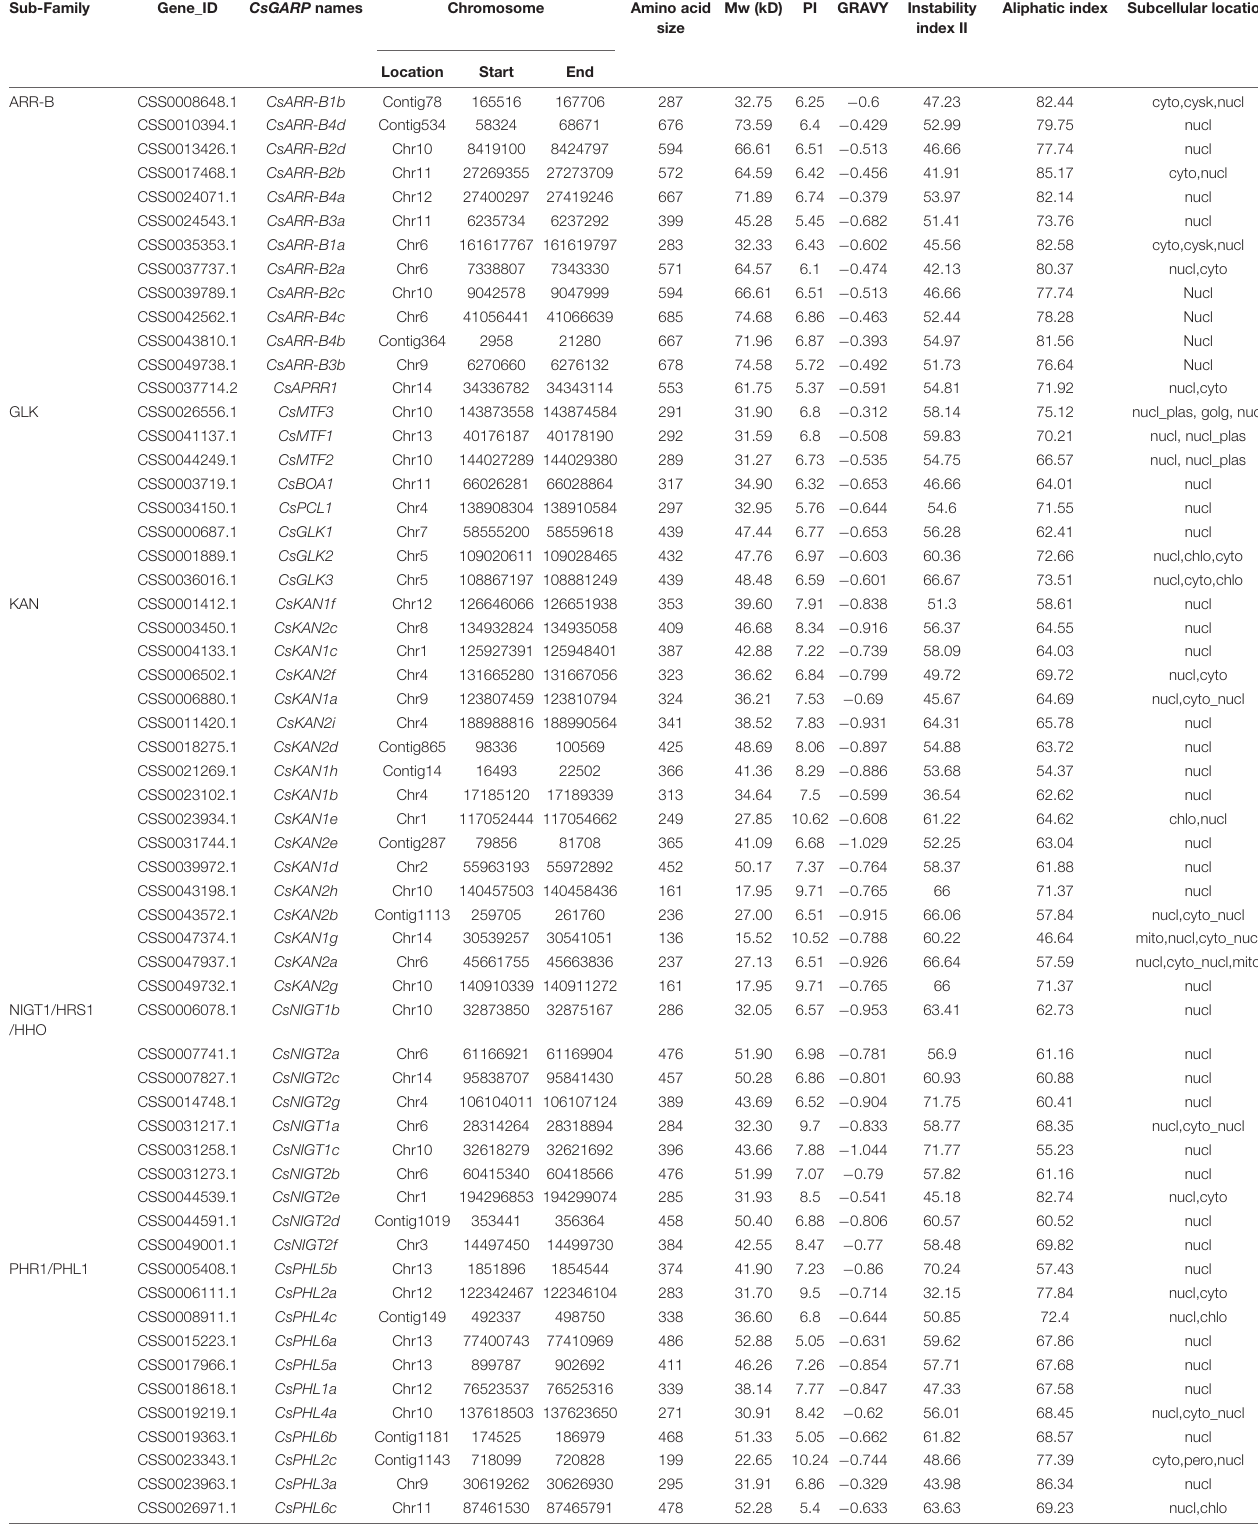
TABLE 1 | Information of CsGARP genes identified in tea plant.